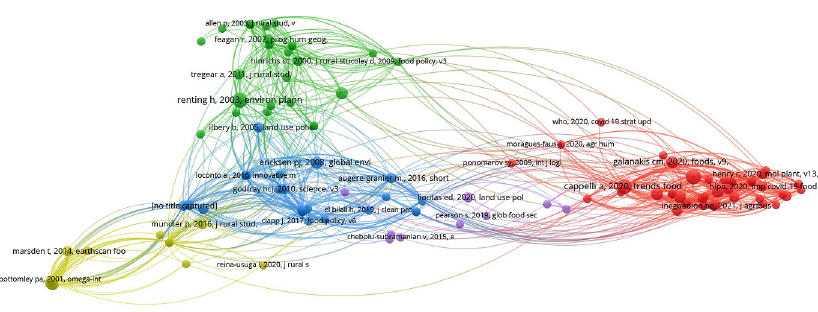
Figure 4. Citation analysis of research in the food security and short supply chain area, 1990–2022 The dense red cluster is centred around Hobbs’ (2020) research, with 38 links and a total link strength of 53. Analysing network-to-network dependency, we found moderate relation- ships with blue and green clusters and only weak interdependences with violet and yellow clusters, indicating the distinctiveness of the red cluster research, which is generally based on the Covid-19 effects on food supply chains and networks. The green cluster is based